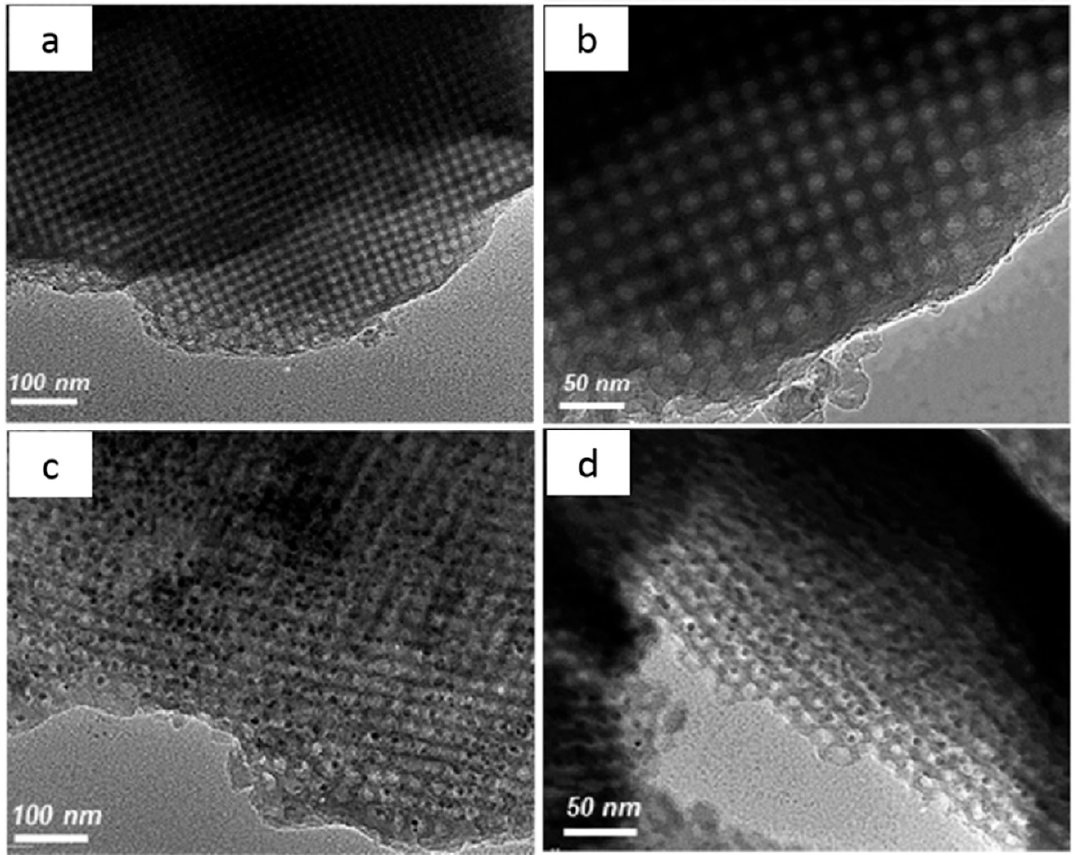
Figure 8. HRTEM micrographs of ( a , b ) NH 2 -FDU-12 silica matrix and ( c , d ) HKUST-1 / FDU-12 composite viewed at lower ( a , c ) and higher ( b , d ) magnifications. Reproduced from [112], with permission from the Royal Society of Chemistry, 2017.